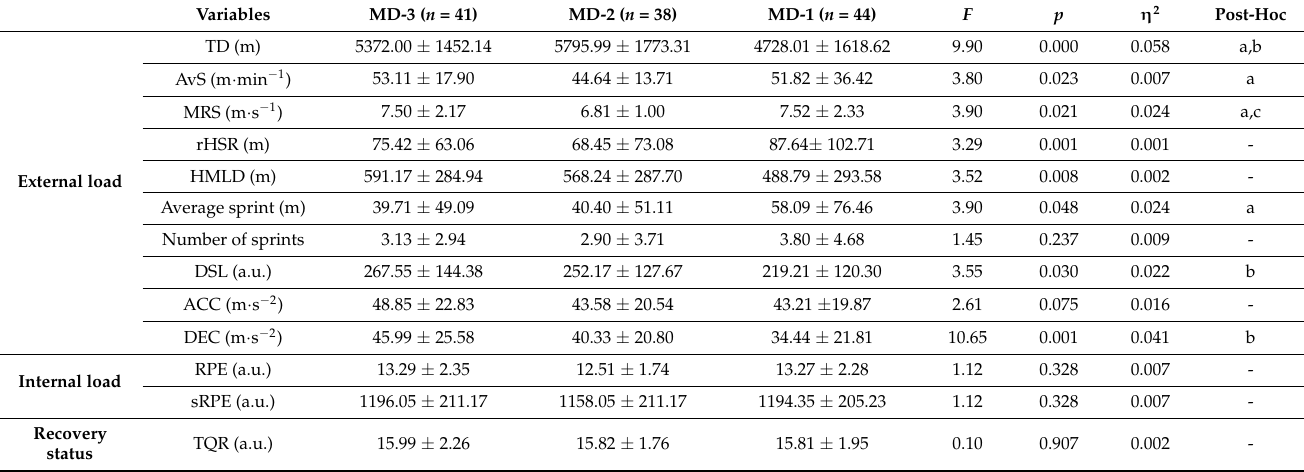
Table 2. Mean training load and recovery status per session for each training day examined.